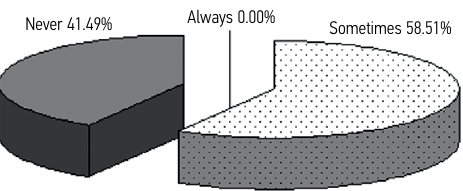
Fig. 3. Hands-free devices usage while driving